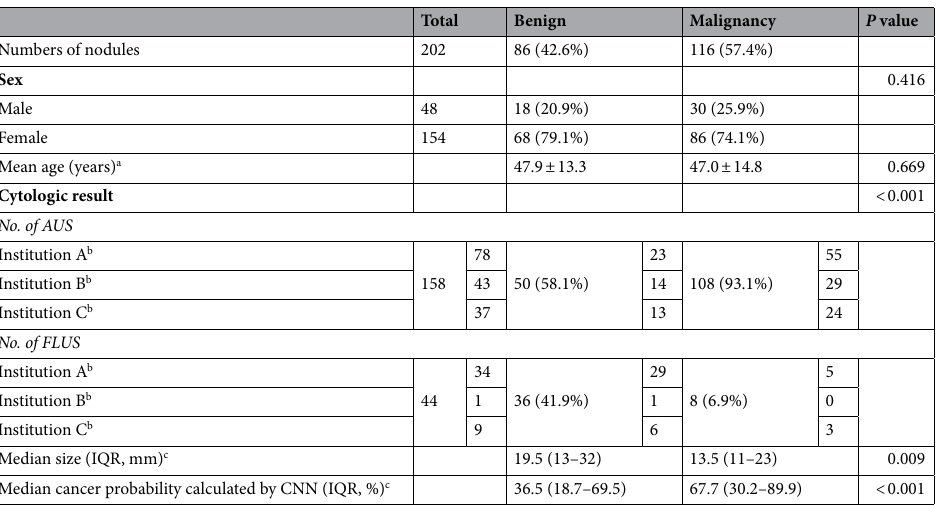
Table 1. Summary of the demographic features. AUS atypia of undetermined significance, FLUS follicular lesion of undetermined significance, IQR interquartile range, CNN deep convolutional neural network. a The independent two sample t-test. b We collected consecutive patients from three institutions, and the numbers of patients recruited from each hospital was expressed as Institution A, B, and C. c The Mann–Whitney U